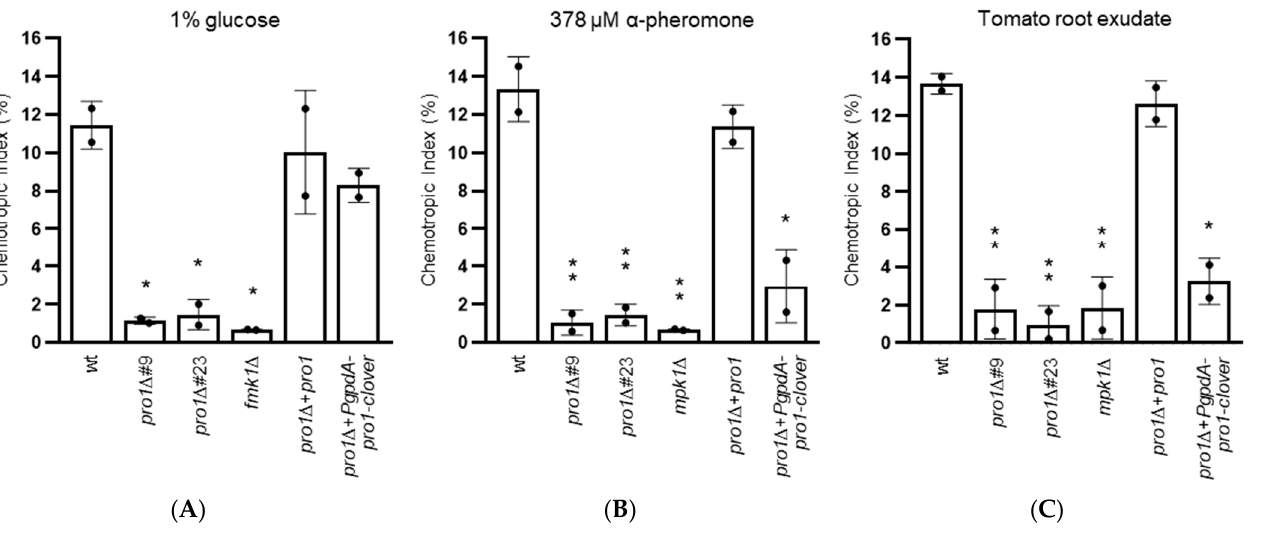
Figure 4. Pro1 is required for hyphal chemotropism towards nutrients ( A ), sex pheromone ( B ) and plant roots ( C ). Directed growth of germ tubes of the indicated strains towards a gradient of indicated chemoattractants was determined. Data show means ± s.d. *, p < 0.05; **, p < 0.01 versus wt according to Yates’ corrected chi-squared test (two-sided).